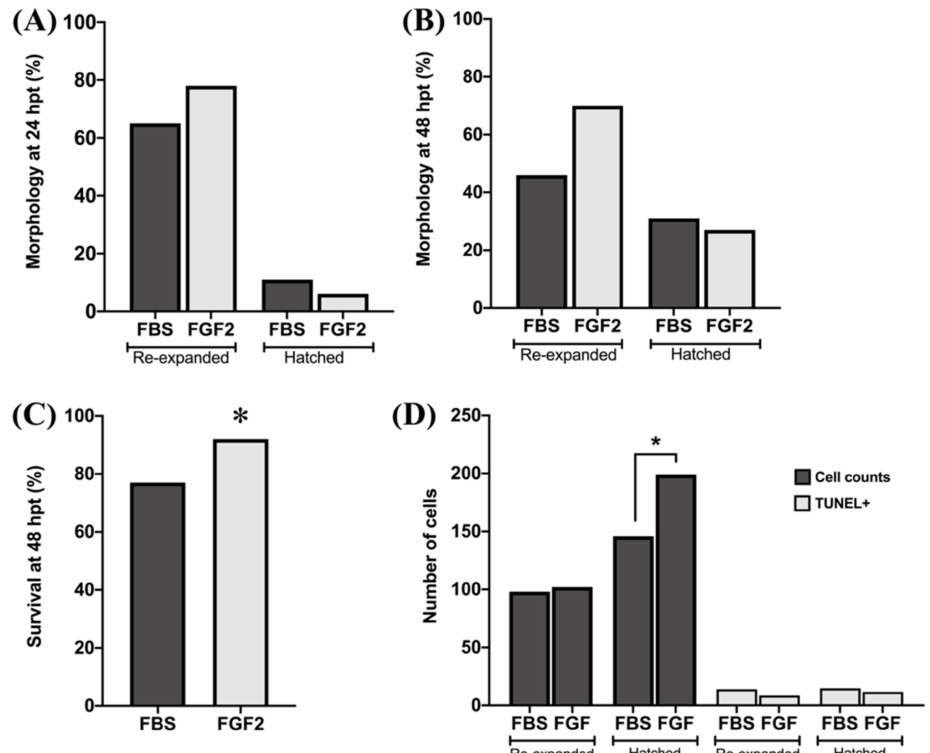
Figure 1. Effect of embryo culture system (defined vs. undefined) on the morphology, survival rate and cell count of vitrified embryos after warming. Embryos were analyzed at 24 h ( A ) and 48 h post thawing ( B – D ). FBS: fetal bovine serum; FGF2: fibroblast growth factor 2. Cell counts: total number of cells. TUNEL+: cells positives to the terminal deoxynucleotidyl transferase dUTP nick end labeling. * p <